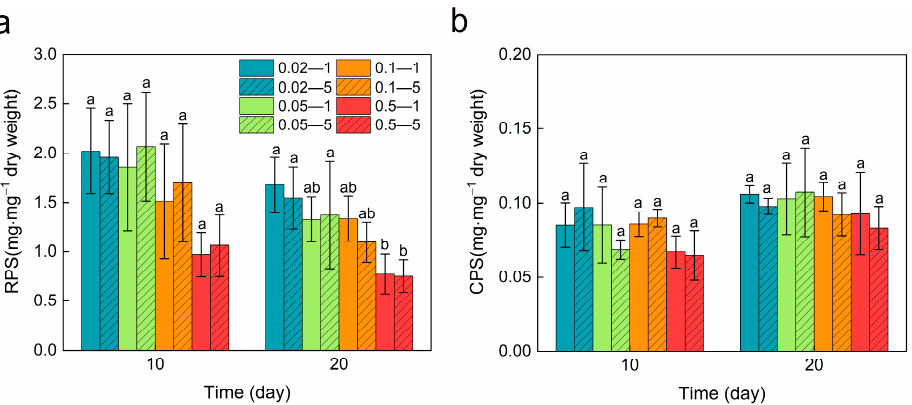
Figure 5. The changes in RPS ( a ) and CPS ( b ) of C. ovalisporum in the different treatments. All the values are means ± S.D. Identical letters denote no significant difference ( p <